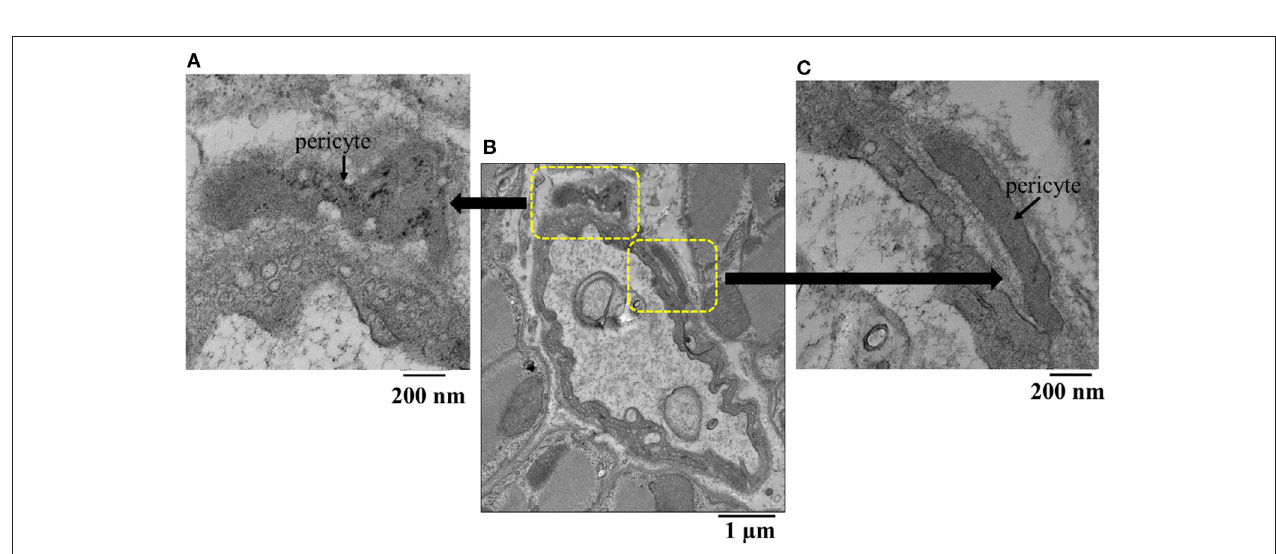
FIGURE 5 | (B) Example of an epicardial capillary with multiple invaginations and surrounded by pericytes shown in high magnification inserts (A,C)